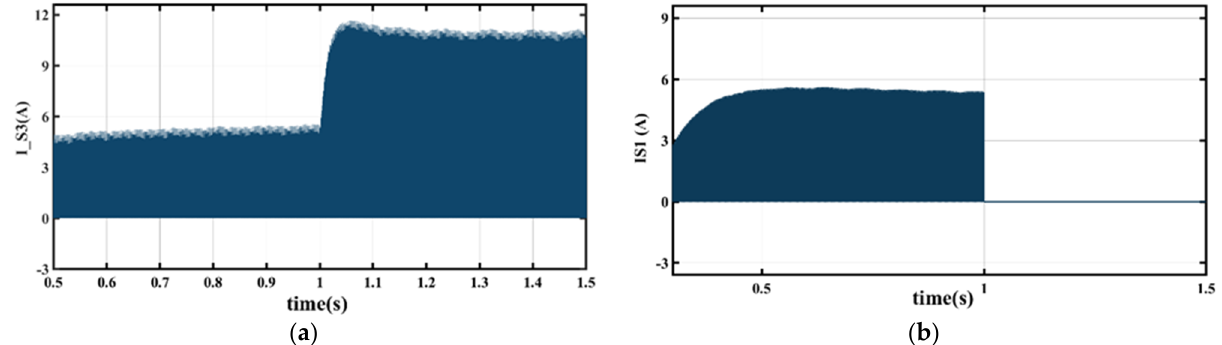
Figure 10. Simulation results during an OCF on power switch S1 in forward mode: ( a ) current of switch S3 during an OCF on power switch S1 ; ( b ) current of switch S1 during an OCF.